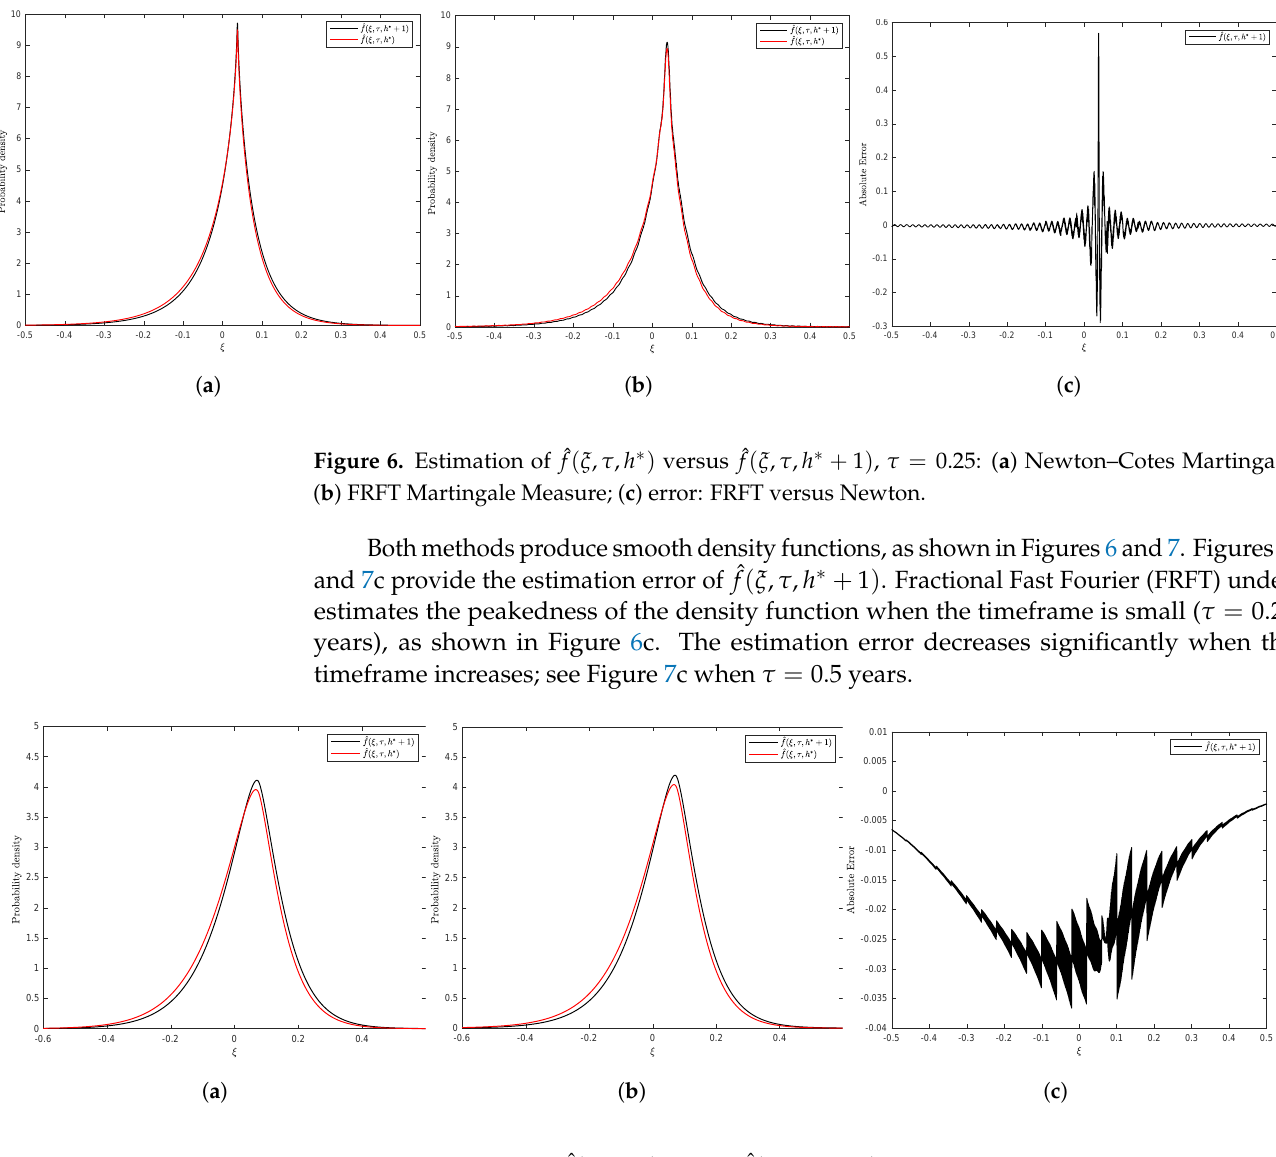
Figure 7. Estimation of ˆ f ( ξ , τ , h ∗ ) versus ˆ f ( ξ , τ , h ∗ + 1 ) , τ = 0.5: ( a ) Newton–Cotes Martingale; ( b ) FRFT Martingale Measure; ( c ) error: FRFT versus